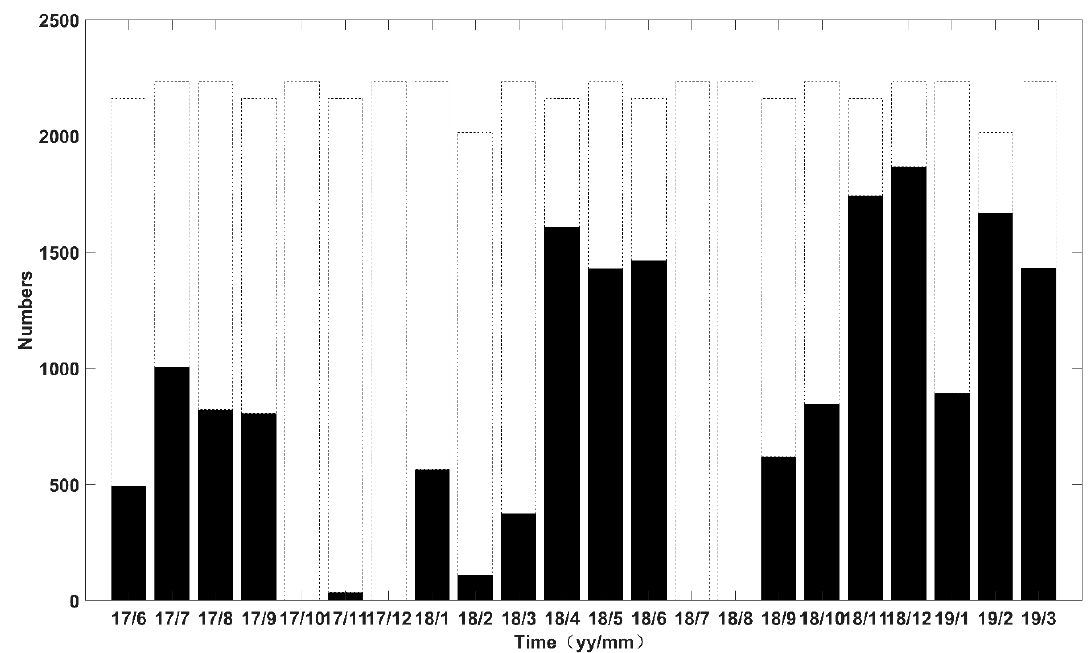
Figure 2. Number of HFR-derived surface current field records for each month. The data are recorded once every 20 min. Shaded areas indicate the number of data for each month.